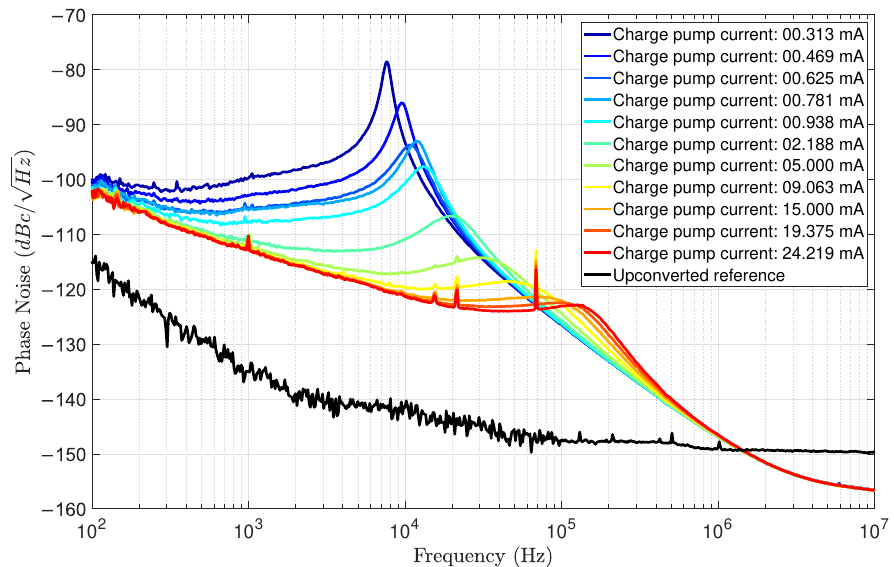
Figure 7. The phase noise spectra of frequency translated reference signal and unmodulated signal at the LMX2592 output for a range of charge pump current values. Reference frequency 125 MHz, output frequency 1 GHz, and VCO frequency 4 GHz. Reprinted with permission from ref. [7]; Copyright 2021